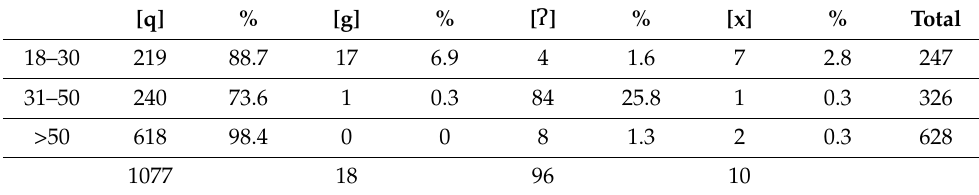
Table 7. Age distribution voiceless uvular and its